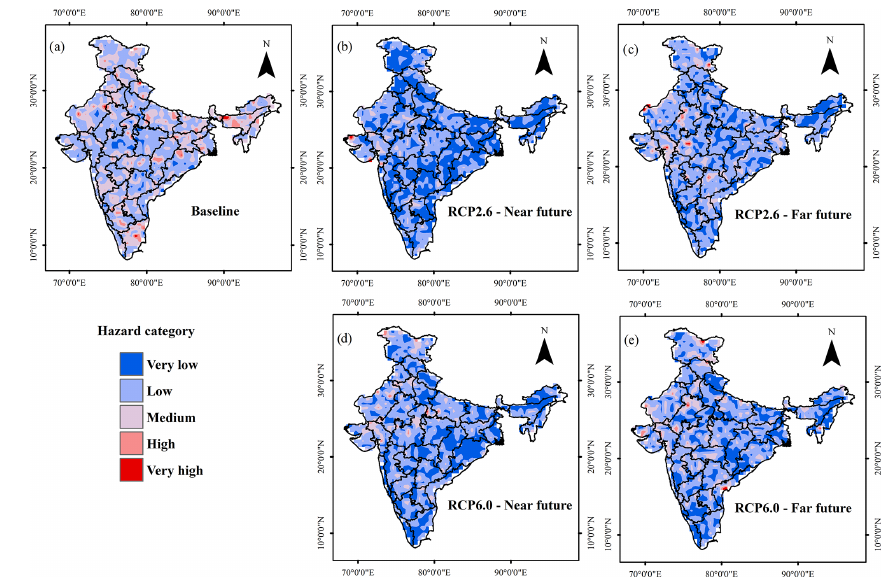
Figure 3. Multi-model ensemble drought hazard maps for the scenarios (a) baseline, (b) RCP2.6-Near future, (c) RCP2.6-Far future,